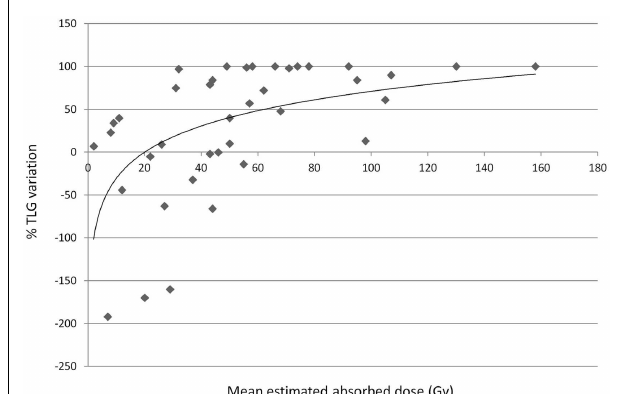
FIGURE 5 |Tumor response related to variation of theTLG with absorbed doses (Gy) . T response by means of theTLG variation in FDG-PET examinations versusT absorbed dose. Regression analysis ( R 2 = 0.26). Errata corrige of previously published data by Flamen et al. (35). Data provided by the authors, personal